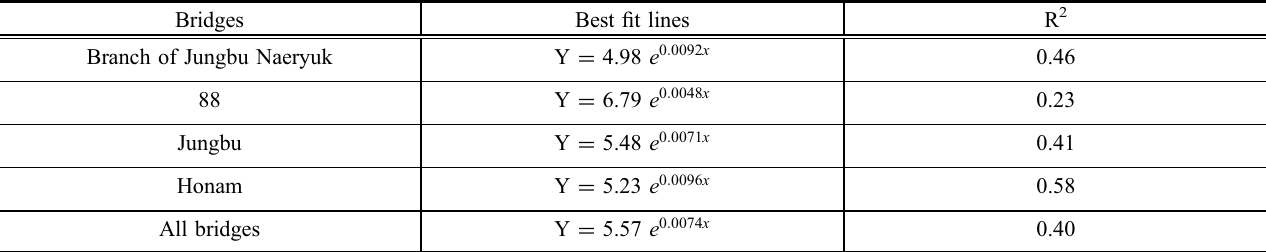
Table 3 Summary of equations for best fit lines and goodness of fit (R-squares) for old